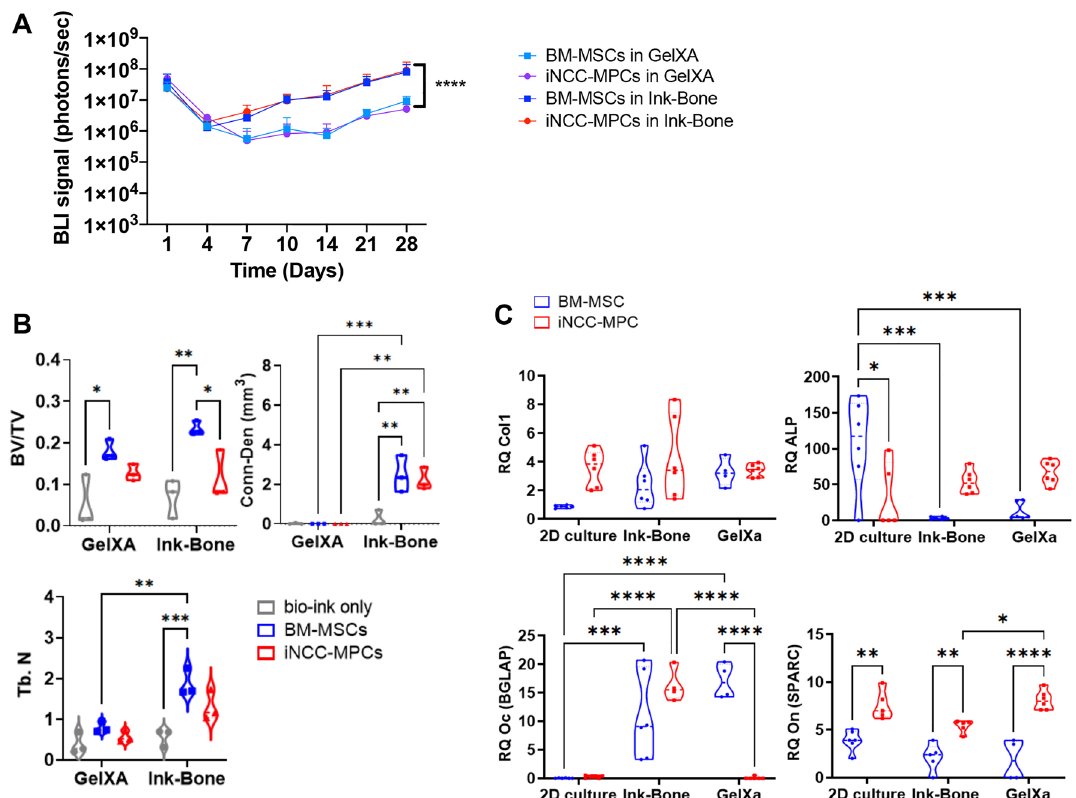
Figure 3. Cell viability and in vitro bone formation increased in the Ink-bone group. A. Cells were labeled with a Luciferase reporter gene and their viability in the two bio inks was assessed by BLI in vitro. N ≥ 4. B. Cells were cultured in 2D or in bio-ink 3D constructs in osteogenic media. Osteogenic gene expression was tested on Day 10. N ≥ 4. C. In vitro bone formation of cells in the bio-inks was evaluated using µCT at 3 weeks and compared to Ink-Bone only. N = 3. * p < 0.05, ** p < 0.01, *** p < 0.001, **** p <